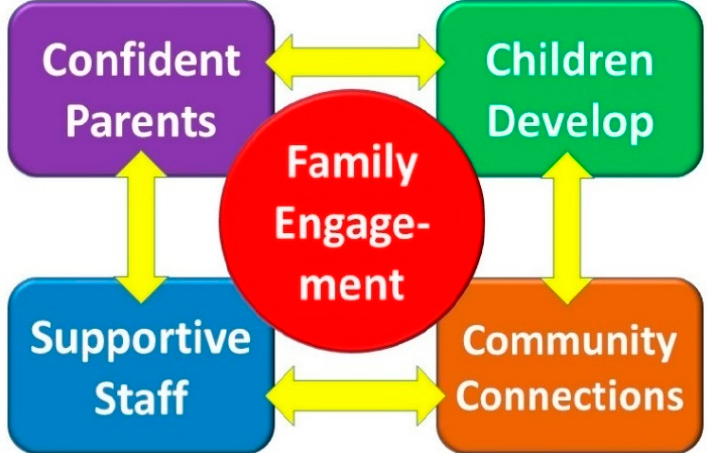
Figure 1. The themes identified in parents’ perceptions of family-centred support.